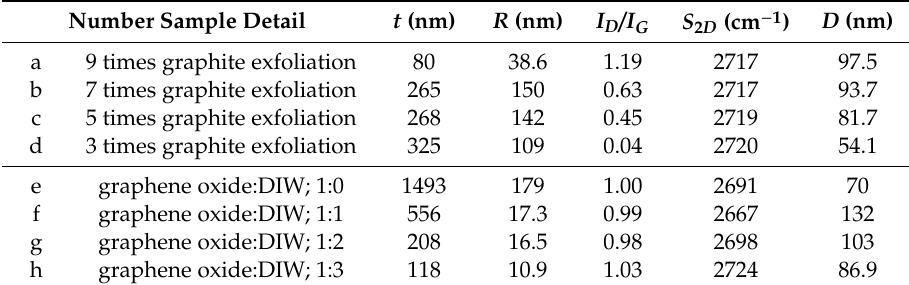
Table 1. Nanomechanical membrane (NMM) characteristics 1 .